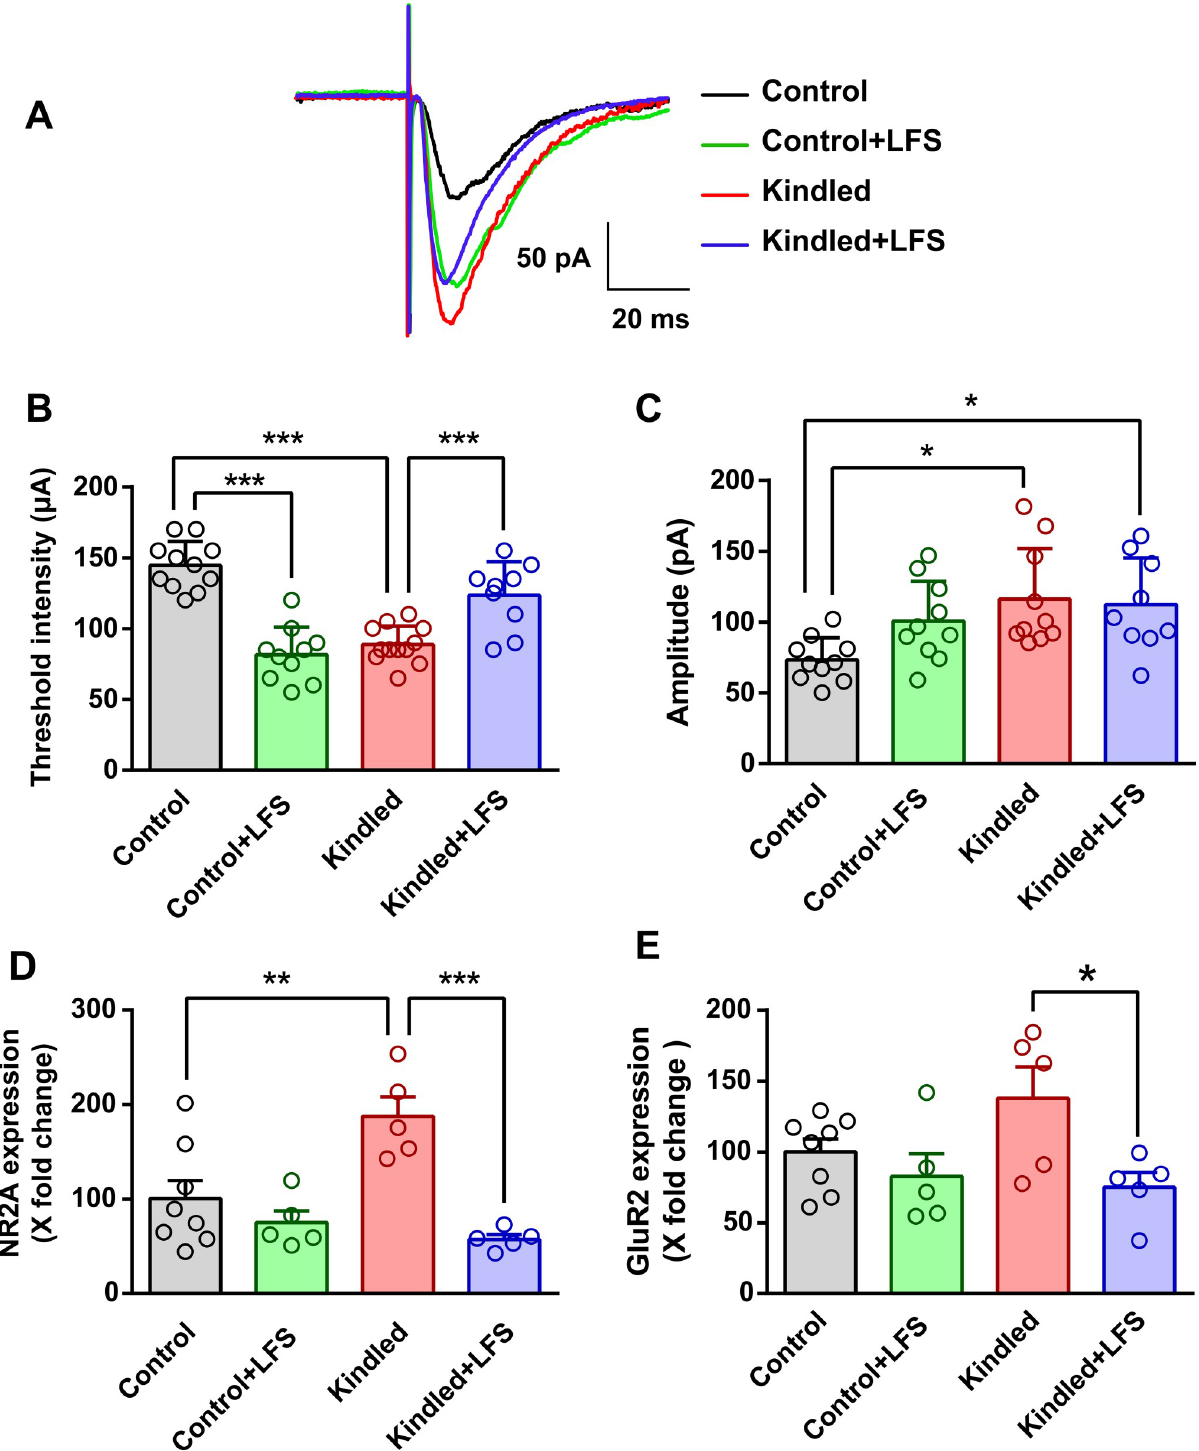
Fig 5. Effect of LFS on currents and gene expression of glutamatergic receptors. (A) Sample recording of evoked EPSCs in different experimental groups. (B) Effect of LFS on the threshold intensity of EPSCs in different experimental groups. In the kindled group, threshold intensity to evoke the EPSC decreased significantly compared to the control group. Application of LFS in kindled animals increased this parameter. Similar to the kindled group, application of LFS alone in control animals decreased the threshold intensity as compared to the control group. Control: n = 10, Control+LFS: n = 10, Kindled: n = 10, Kindled+LFS: n = 9. (C) Effect of LFS on the amplitude of EPSCs in different experimental groups. Amplitude of EPSCs in